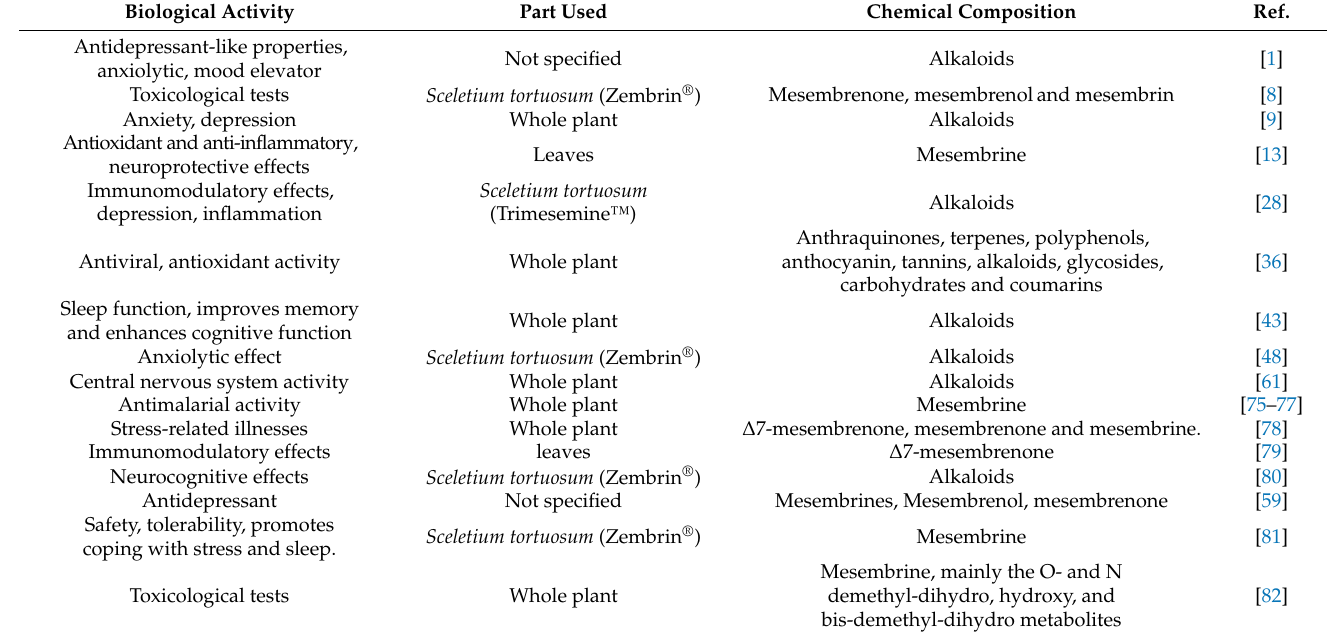
Table 1. Biological investigation of Sceletium